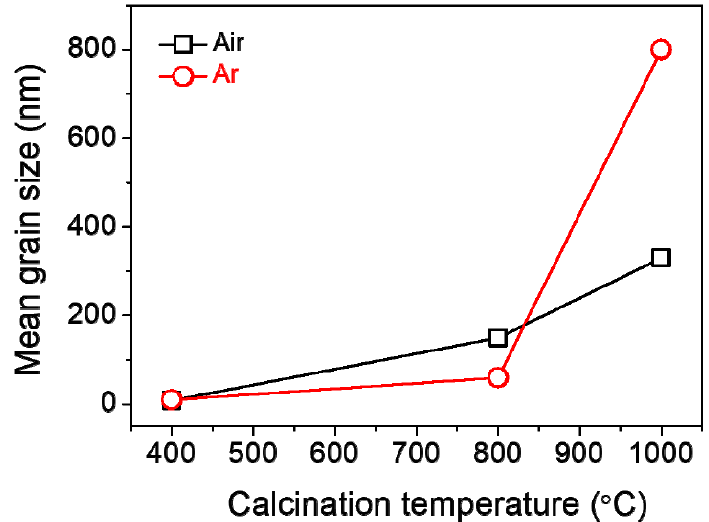
Figure 7. Mean grain size shown as a function of calcination temperature for the films prepared in air and